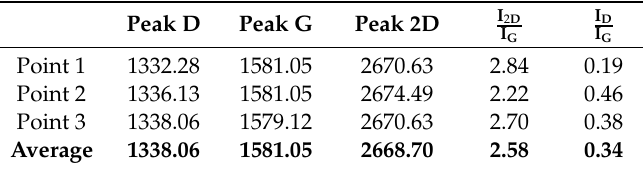
Table 2. Raman spectroscopy data for graphene on